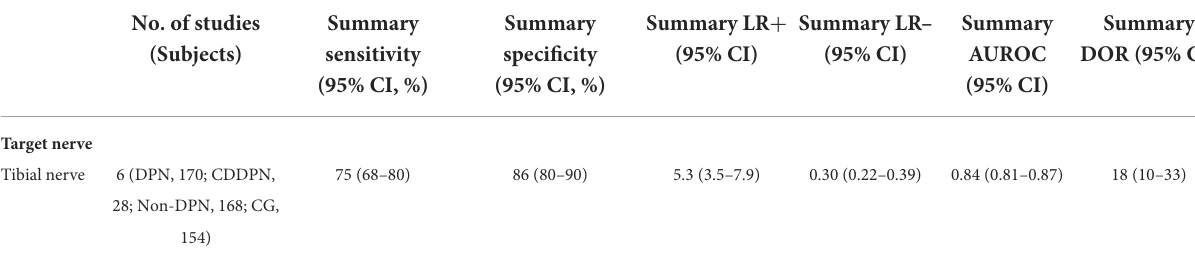
TABLE 4 Meta-analysis results of the stiffness of the tibial nerve using SWE for prediction of DPN. No. of studies